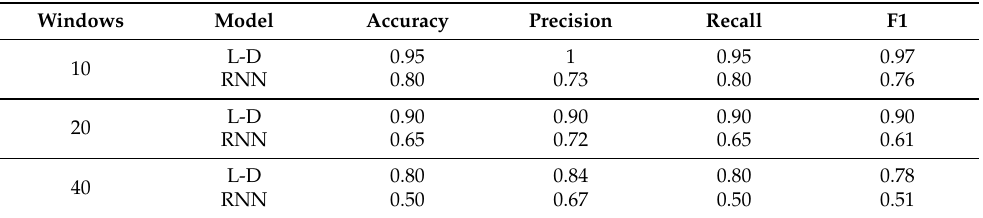
Table 11. Comparison between L-D model and RNN